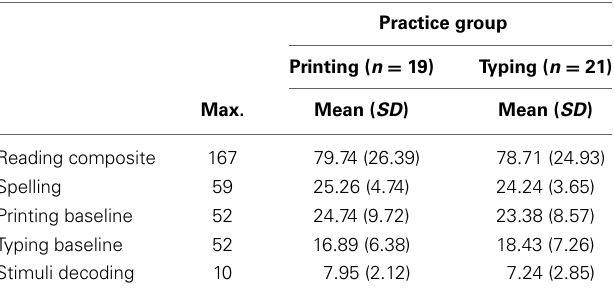
Table 1 | Initial assessment performance as a function of practice group.